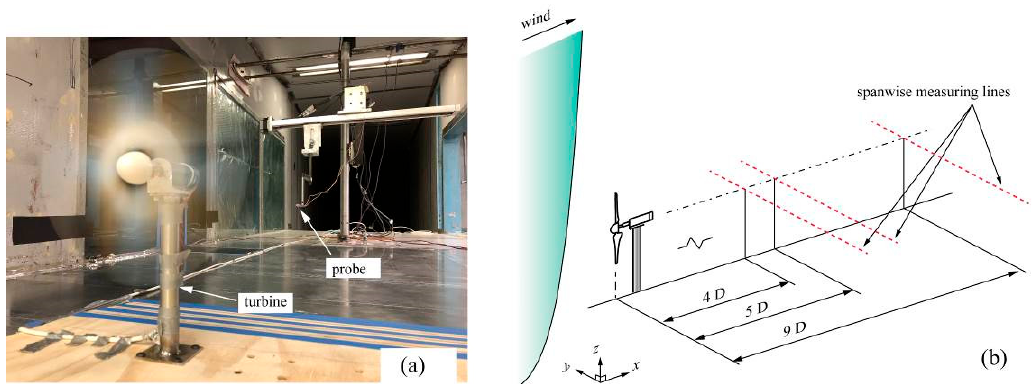
Figure 2. ( a ) Photograph of the turbine model and hot-wire probe in the SAFL (St. Anthony Falls Laboratory) wind tunnel; ( b ) corresponding schematic diagram of measurement locations at hub height, where D is the diameter of a turbine rotor.